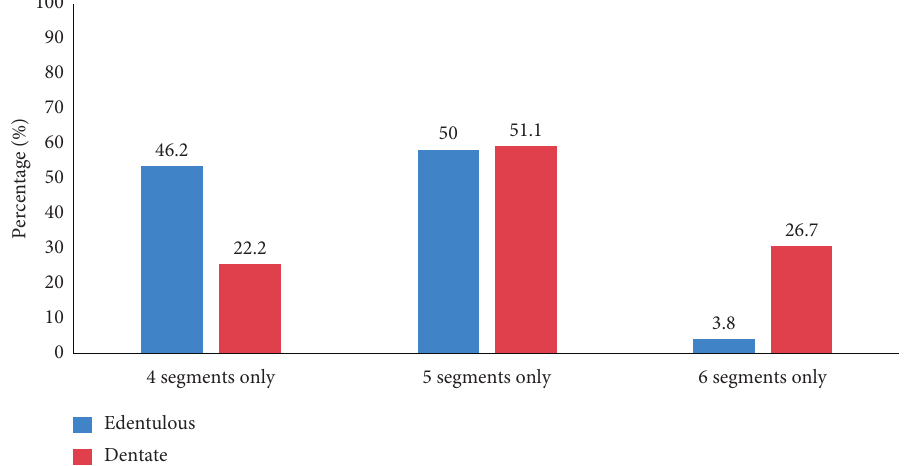
Figure 2: Percentage of edentulous and dentate mandibles with different numbers of segments.